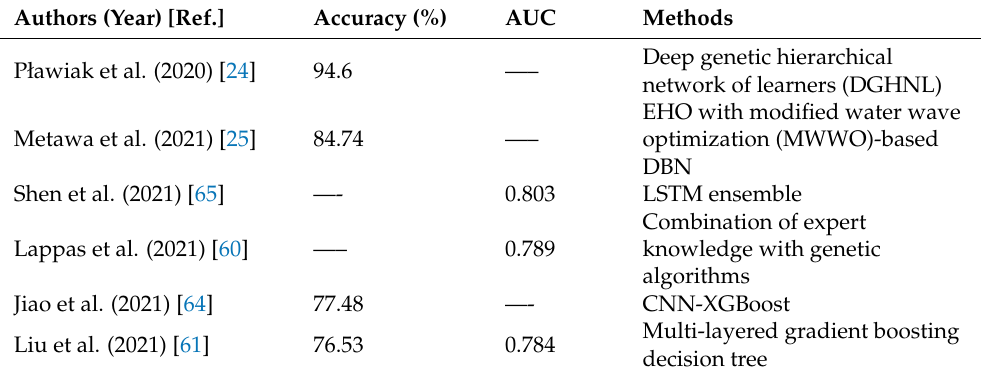
Table 9. Accuracy and area under the receiver operating characteristic curve (AUC) values of deep-learning-based classifiers for the German (numerical) dataset.